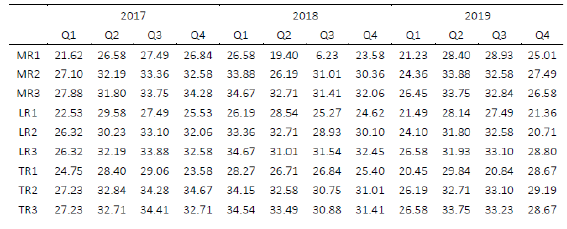
Table 3 . Model derived Chlorophyll